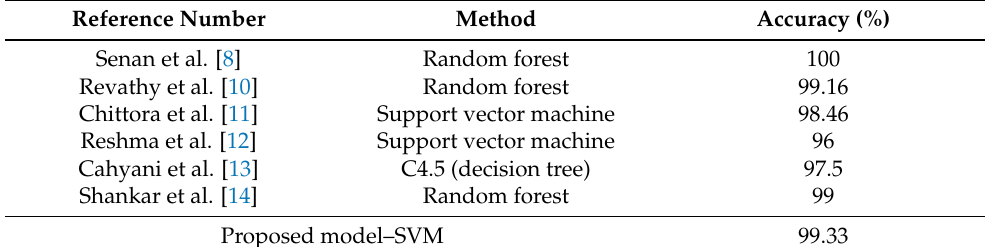
Table 7. Comparative analysis of the various